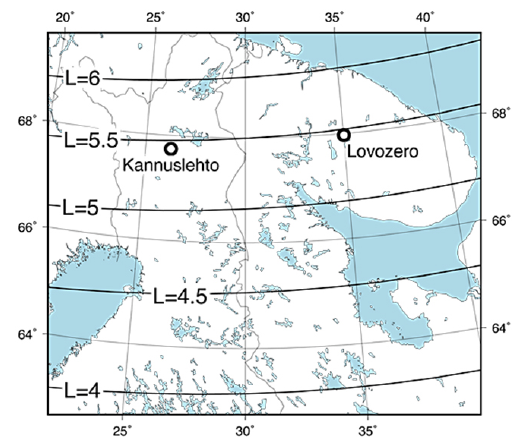
Figure 1. A map of the locations of the stations.